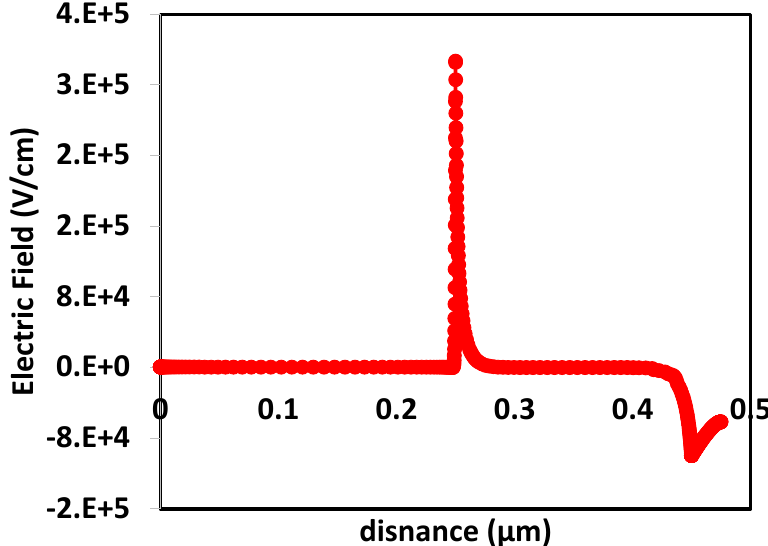
Figure 8. Electric field distribution inside ETL (25 nm)/Cs2TiBr6 (200 nm)/HTL (250 nm) solar cell.